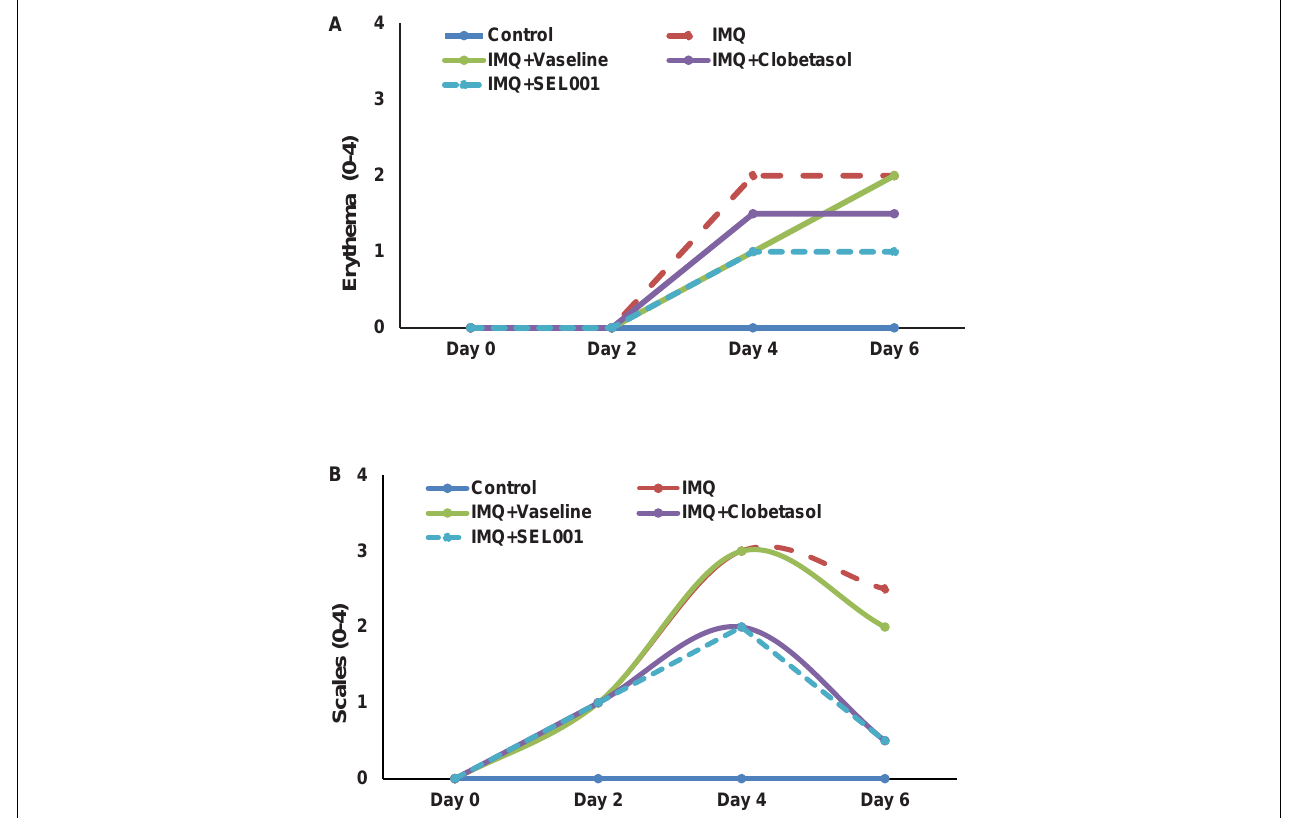
FIGURE 1 | Erythema and scales score of the dorsal skin of the mice. The scoring was performed on 0 day, 2 day, 4 day, and 6 day using the Psoriasis Area Severity Index (PASI). (A) Erythema score and (B) scales score.